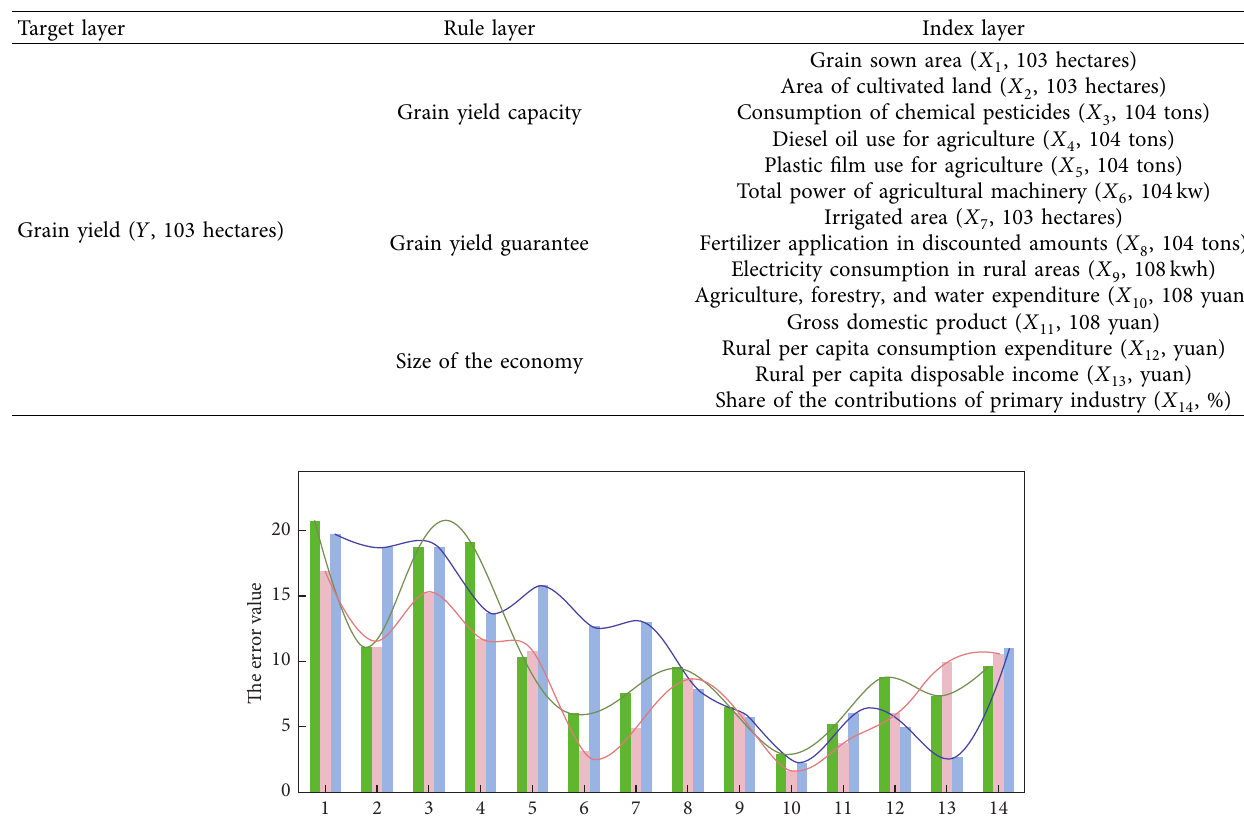
Table 1: Impact factors of grain yield in Henan